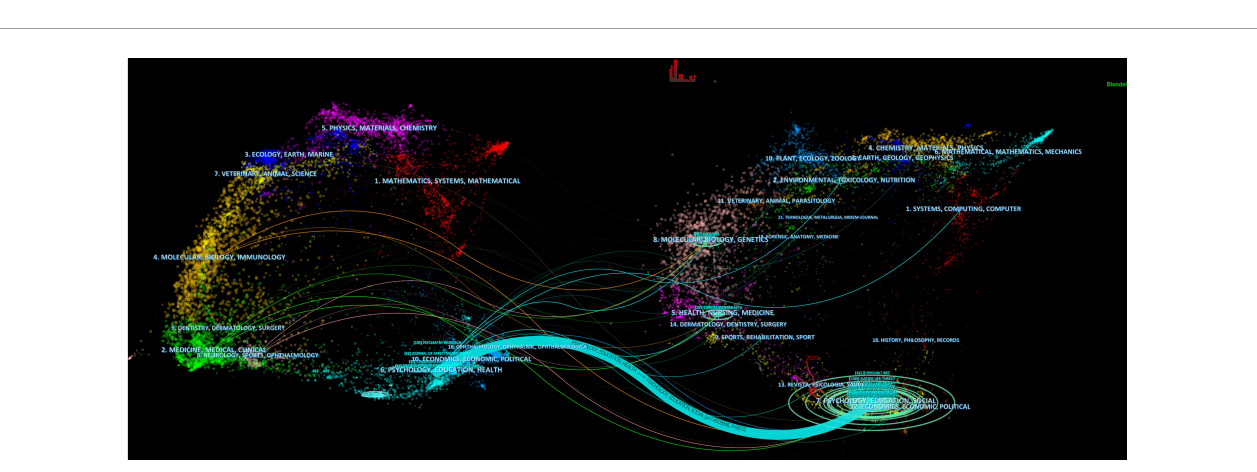
a systematic review and meta-analysis of the prevalence of